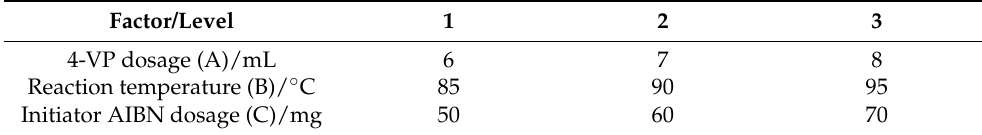
Table 1. Orthogonal test level